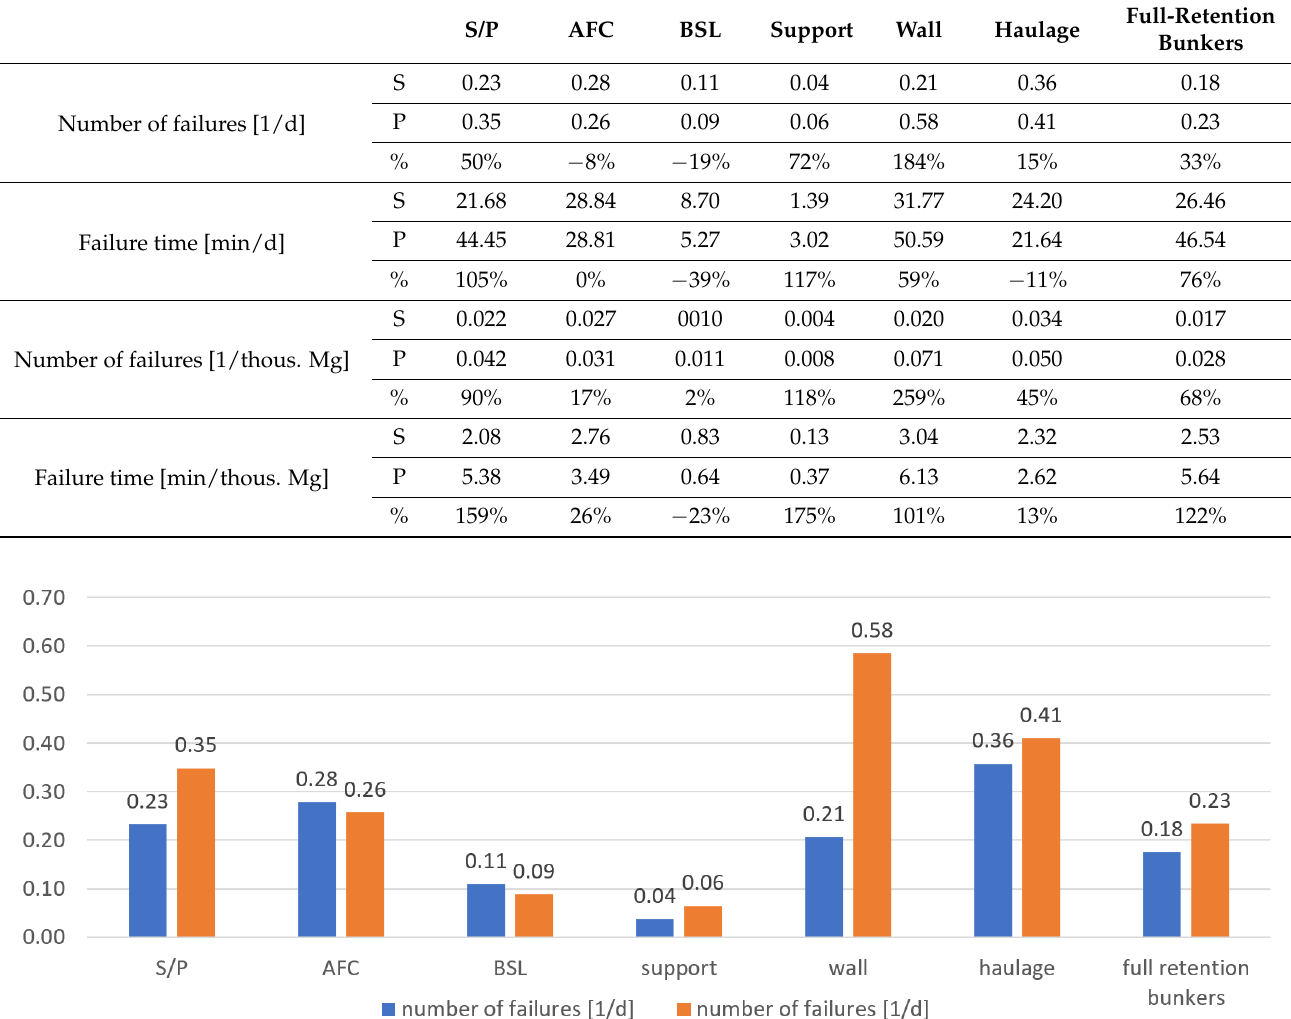
Full-Retention Bunkers Table 6. Comparison of the total failure rates for shearer (S) and plow (P) longwalls. Full-Retenti on Bunkers